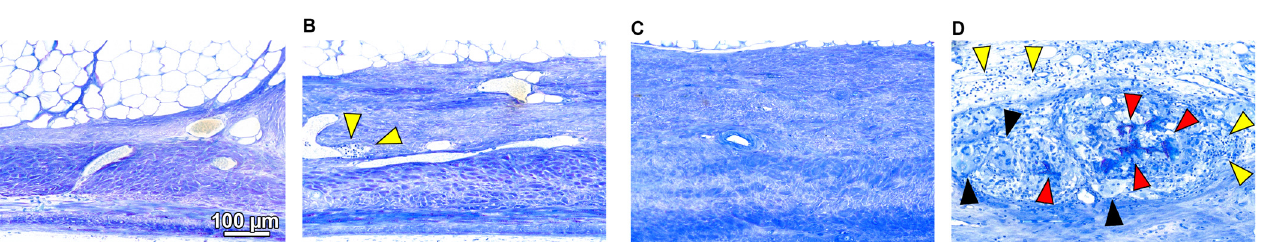
Figure 5. ( A ) Overviews of toluidine blue and fuchsin staining of the defect on the sagittal plane at three months post- surgery. ( B ) Histomorphometry of area parameters including new bone area (NBA, mm 2 ), bone marrow area (BMA, mm 2 ), residual material area (RMA, mm 2 ), connective tissue area (CTA, mm 2 ), adipose tissue area (ATA, mm 2 ), and fibrous tissue area (FTA, mm 2 ). * denotes significant difference between the groups; p < 0.05. ( C ) Summary of area parameters in whole defects (ROI 1), middle area of the defects (ROI 2), and lateral area of the defects (ROI 3).